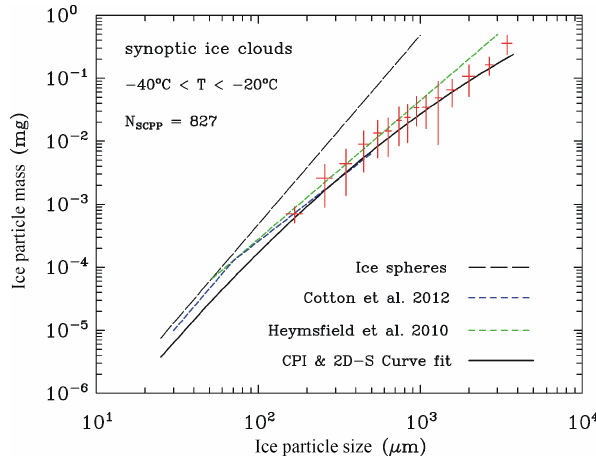
Figure 8. The m - D curve fit based on SCPP and CPI data (for in- dicated temperature regime) is compared with individual ice par- ticle m - D measurements from SCPP, corresponding to ice particle shapes originating from similar temperatures. The number of ice particles sampled in each shape category is indicated. Also shown are comparisons with two other studies that derived m - D power laws from ice cloud field data.